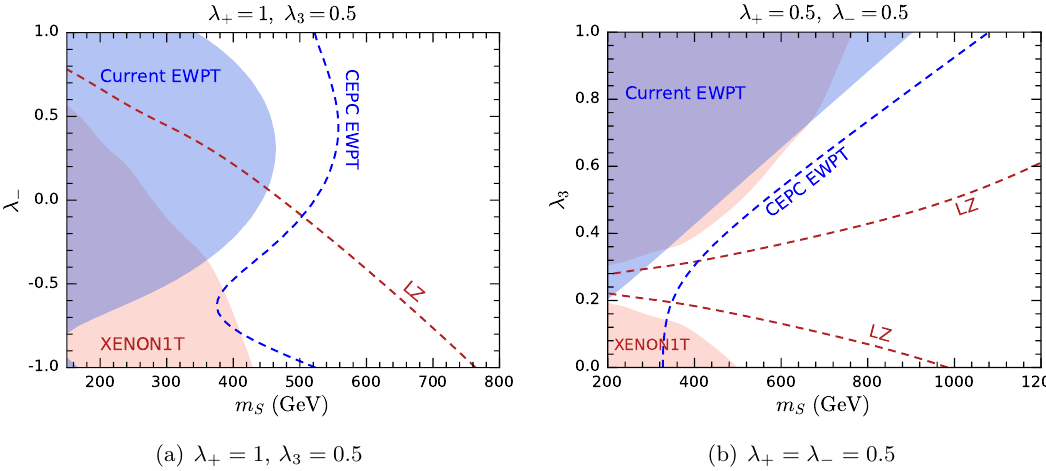
Figure 11 . Current constraints and future sensitivities of EWPT and direct detection in the m S - λ − plane for λ + = 1 and λ 3 = 0 . 5 (a) and in the m S - λ 3 plane for λ + = λ − = 0 . 5 (b). The blue shade regions are excluded at 95% C.L. by the global fit of current EWPT data from the Gfitter Group [92]. The blue dashed lines denote the expected 95% C.L. exclusion limits of the future EWPT at the CEPC [63]. The red shade regions are excluded at 90% C.L. by the XENON1T direct detection experiment [98]. The red dashed lines indicate the expected 90% C.L. exclusion limits of the future LZ direct detection experiment